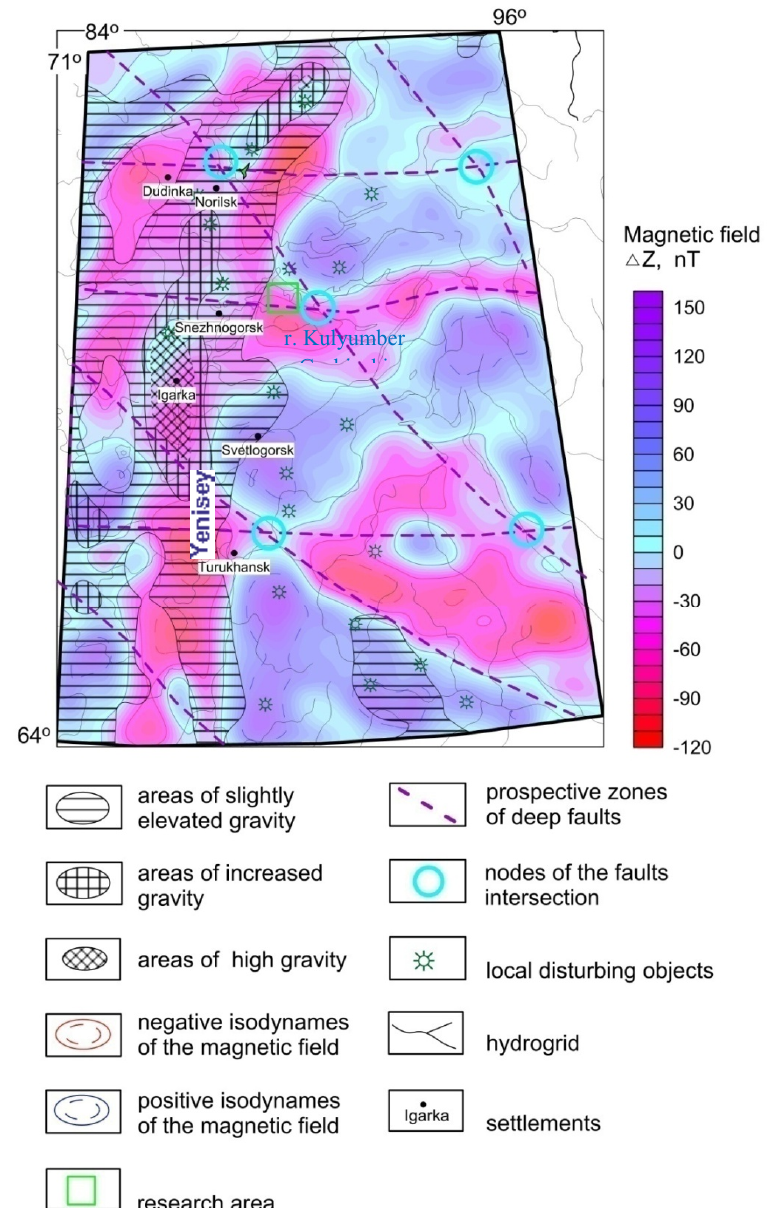
Figure 2. Complex map of magnetic and gravitational fields at the NW Siberian platform (made by the authors based on 1:200,000 gravities and 1:100,000 aeromagnetic mapping at 700- and 2400-m barometric altitudes).